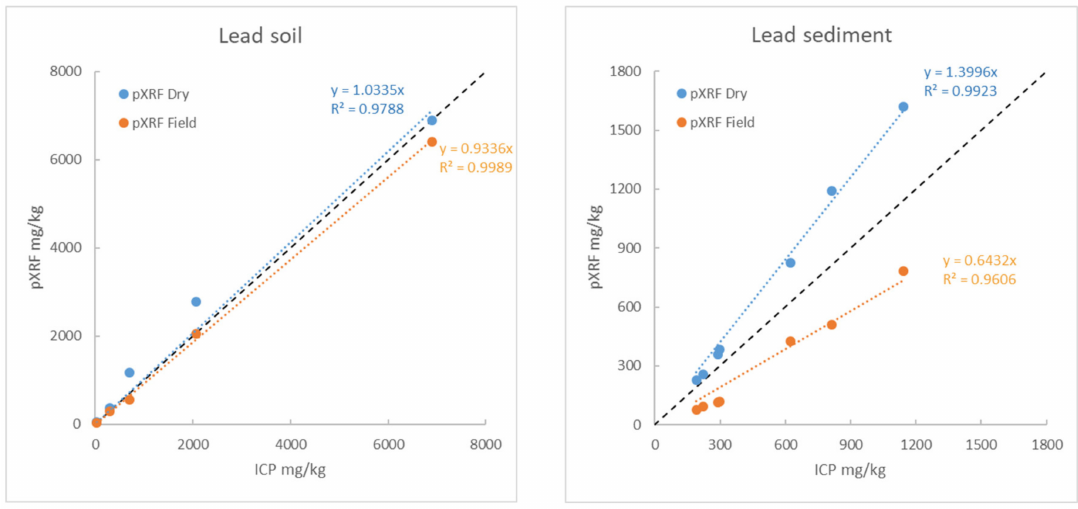
Figure 19. Analyses by pXRF of raw and dried soil samples ( left ) and raw and dried sediment samples ( right